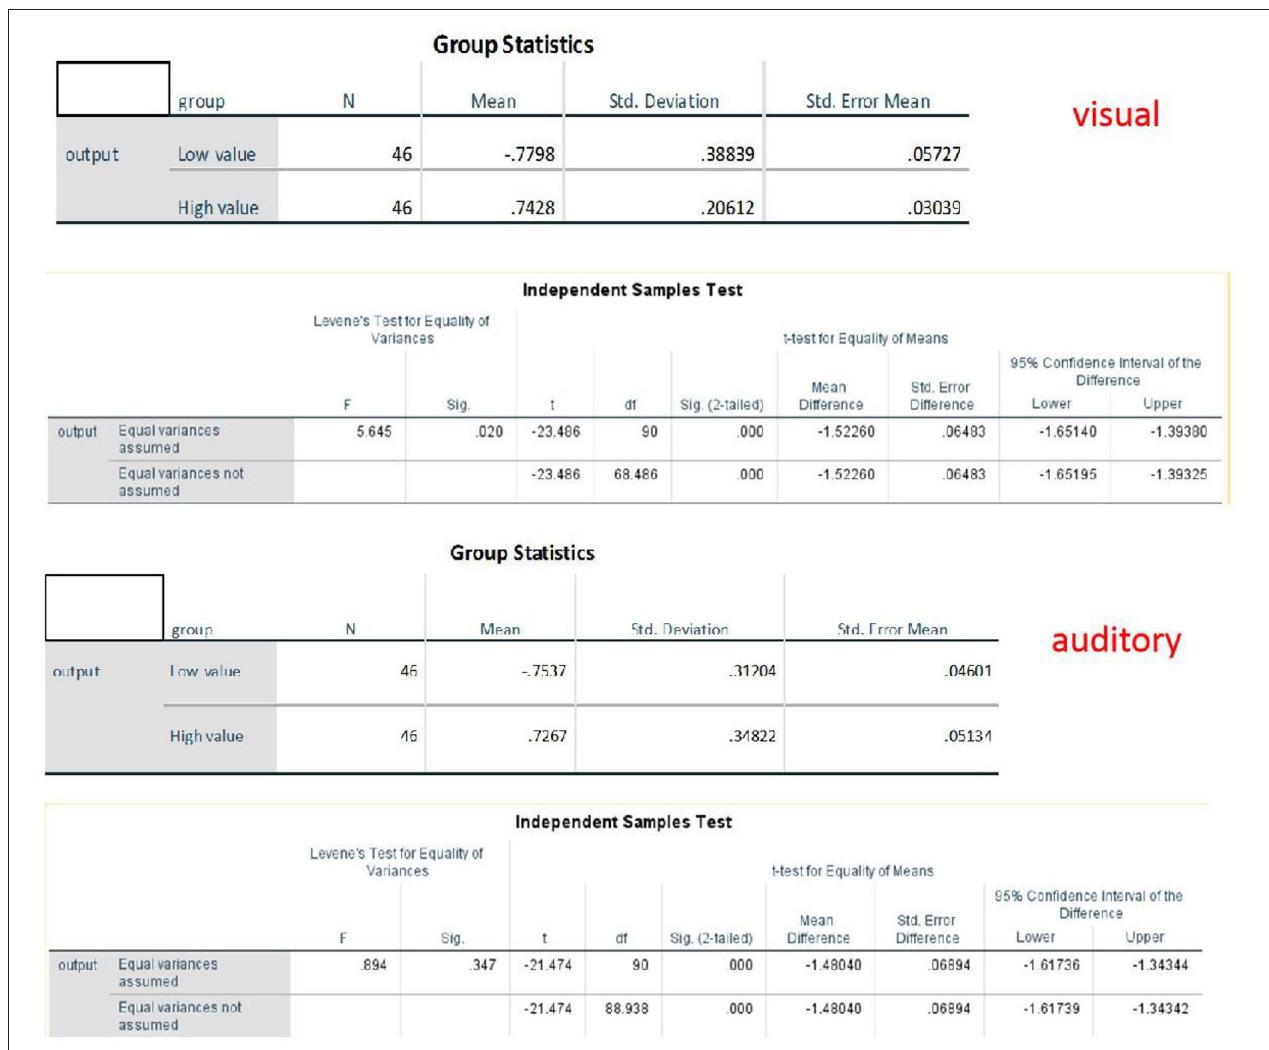
FIGURE 8 | Statistical results of data from visual and auditory brain regions while watching Psycho clip. We have arranged all values from the largest to the smallest, according to the convention of statistical analysis, the high-value group is of the first 27%, and the low-value group is after